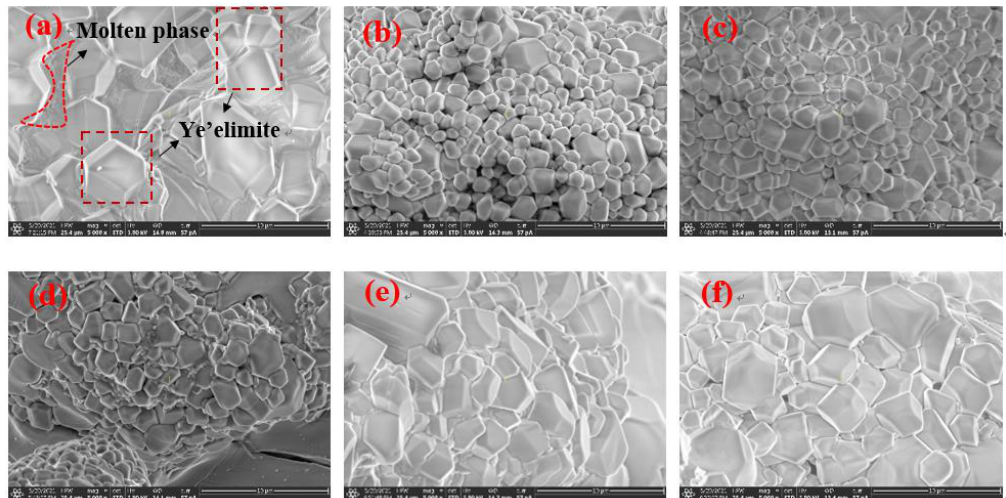
Figure 8. Scanning electron micrograph of section of clinkers S00 ( a ), S10 ( b ), S20 ( c ), S50 ( d ), S80 ( e ) and S100 ( f ).